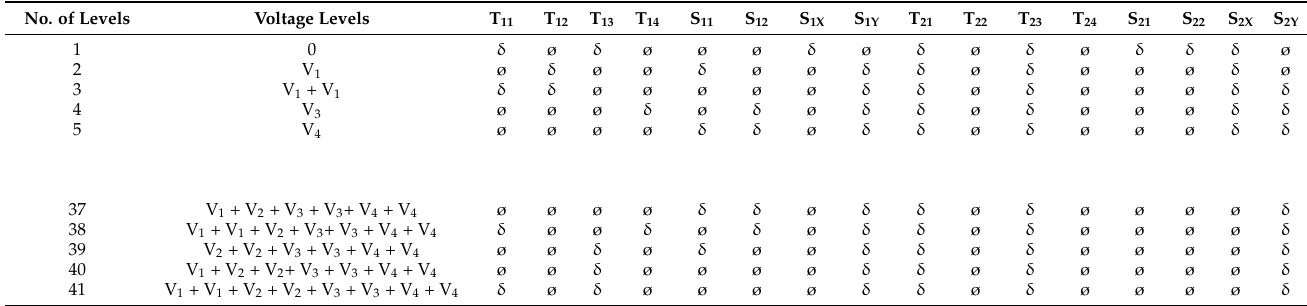
Table 4. Switching sequence for the Proposed SLMLI.